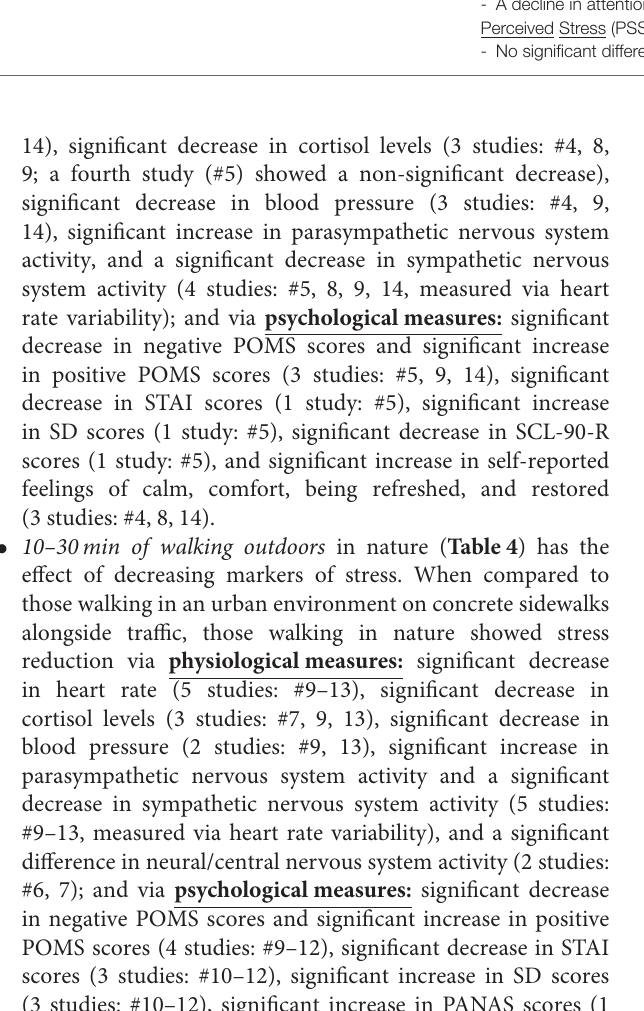
50-min Nature reserve walk